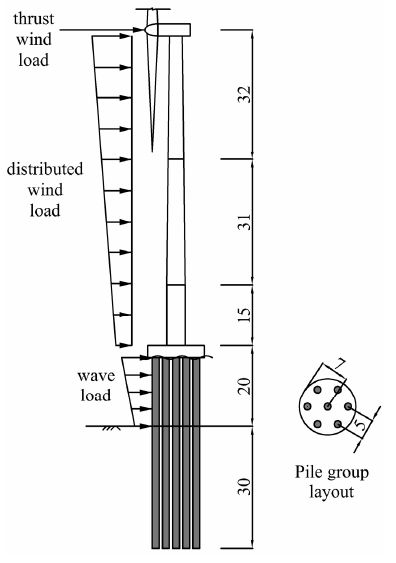
Figure 2. Pile group supported 3.6 MW offshore wind turbine.